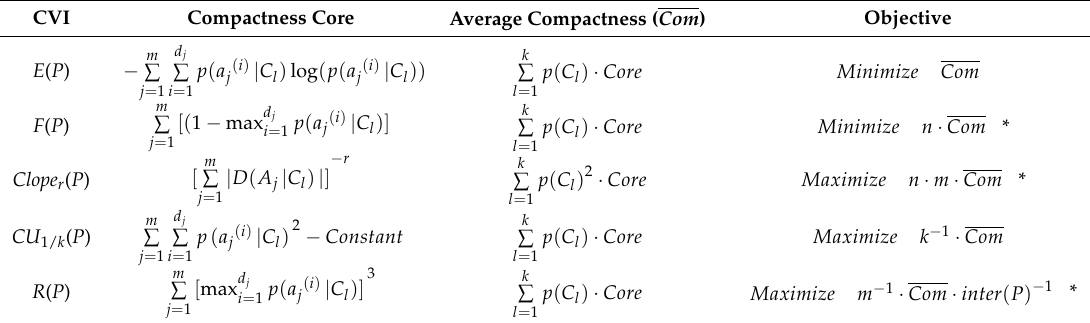
Table 1. Summary of the aforementioned clustering validation indexes (CVIs).